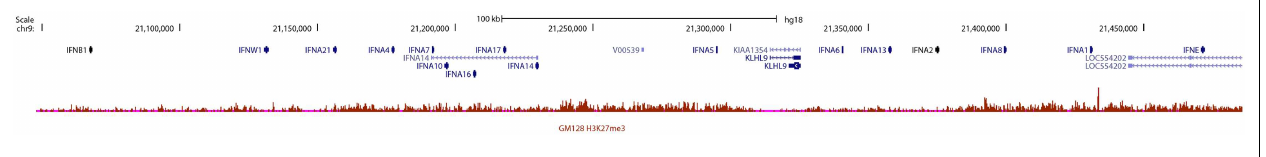
FIGURE 3 | H3K27me3 peaks on the type I IFN gene cluster . Members of the type I IFN gene cluster are shown and illustrated proportionally according to Human ( Homo sapiens ) Genome hg19. H3K27me3 peaks were found along the entire region of the IFN gene cluster in the human B cell line GM128.